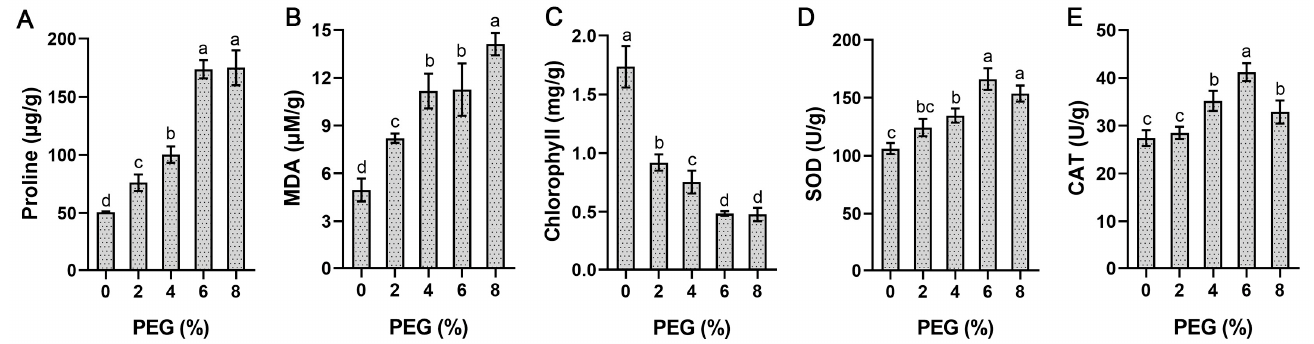
Figure 10. Determination of stress-related physiological indices under different concentrations of PEG stress treatments. Data represent the means ± SD of three replicates, and different letters indicate significant differences at p < 0.05. ( A – E ) Proline content, MDA content, chlorophyll content, SOD activity and CAT activity, respectively.